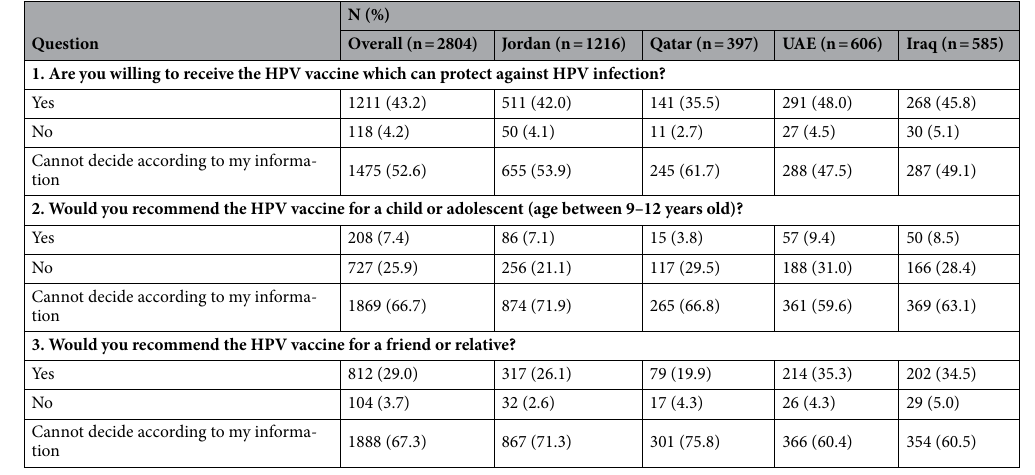
Table 4. Participant’s acceptance of Human Papilloma Virus vaccine (n = 2804).